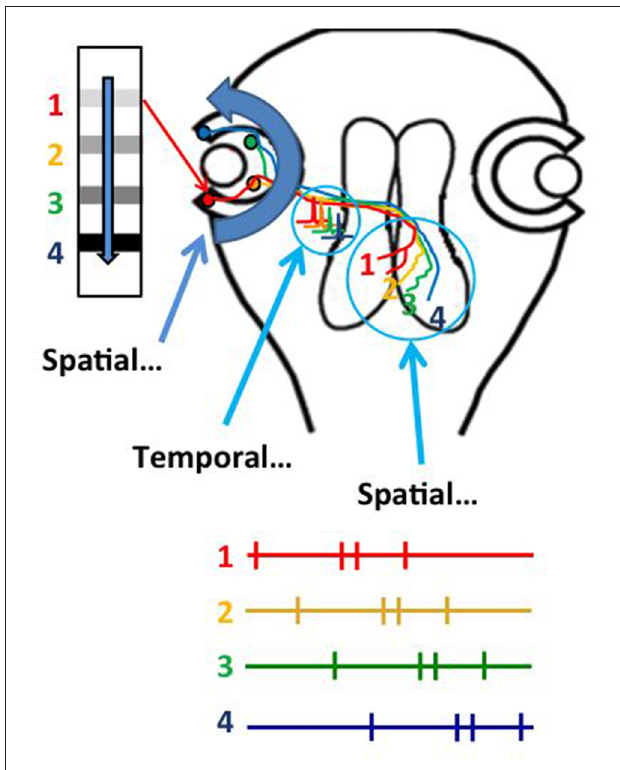
FIGURE 3 | Experience-dependent refinement of the retinotectal map occurs by a spatial to temporal to spatial (STS) transformation of visual information. Natural anterior to posterior motion of objects in the visual scene, or optic flow, activates RGCs from a temporal to nasal sequence, transforming spatial information in the visual scene into temporal information in the sequence of action potential activity in RGCs. The temporal information in firing sequence is transformed into an ordered spatial distribution of RGC axons in the tectal neuropil, based on a rule in which axons that fire first occupy more rostral positions within the tectal target. The STS mechanism ensures that retinal inputs map topographically across the entire target